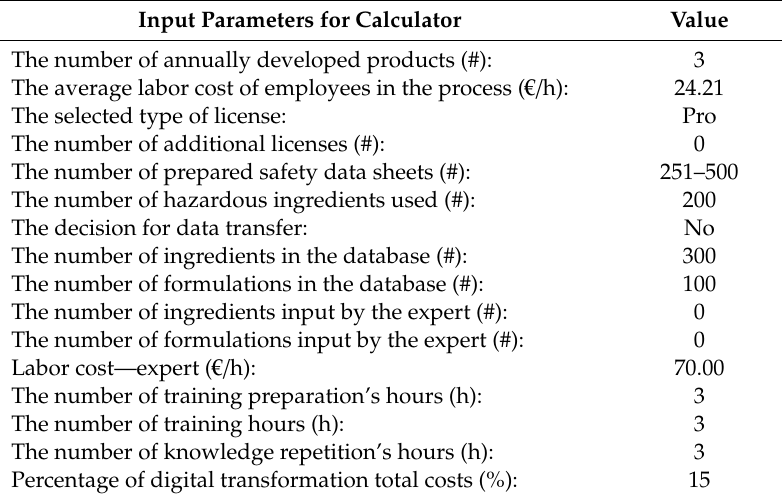
Table 4. Layout of the calculator window of basic data input.